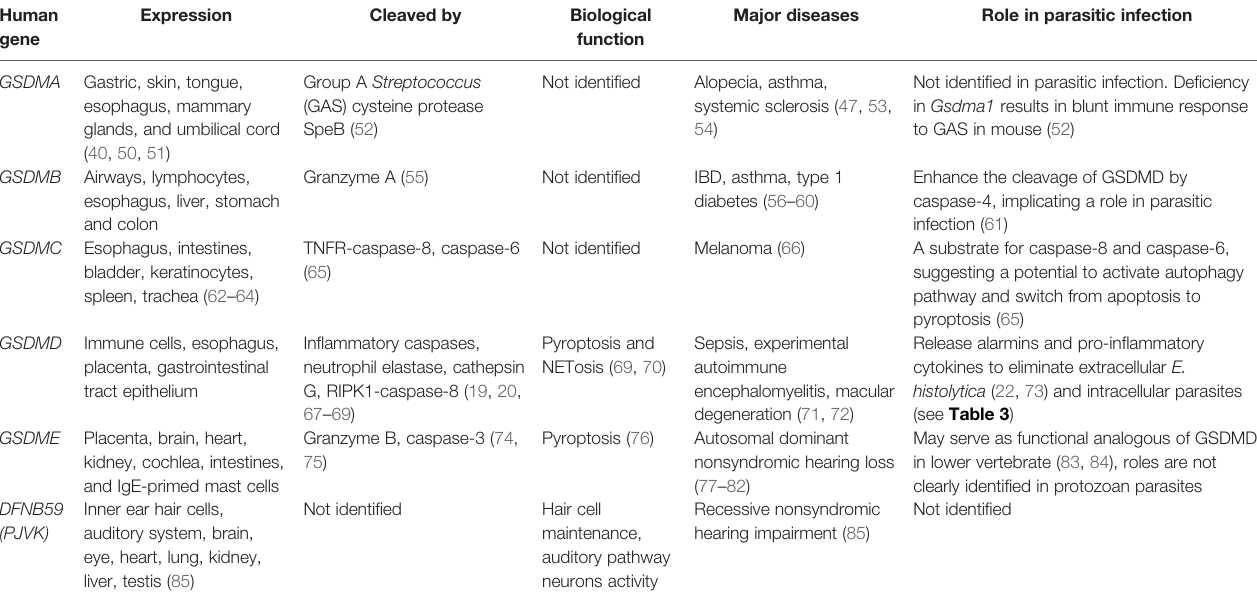
TABLE 1 | Gasdermin family expression patterns and functions in protozoan parasite